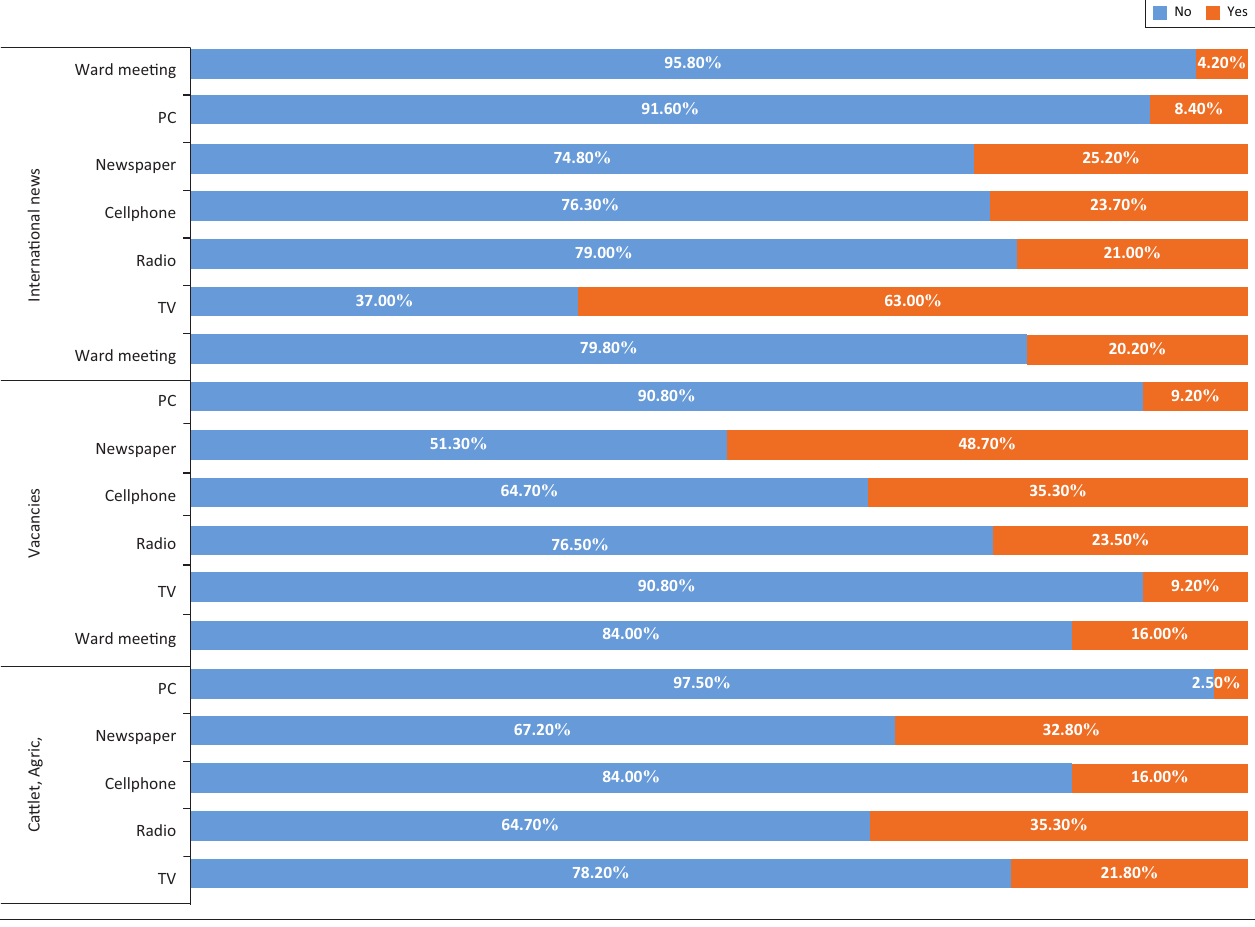
FIGURE 3: Devices used to access information on international news, jobs and